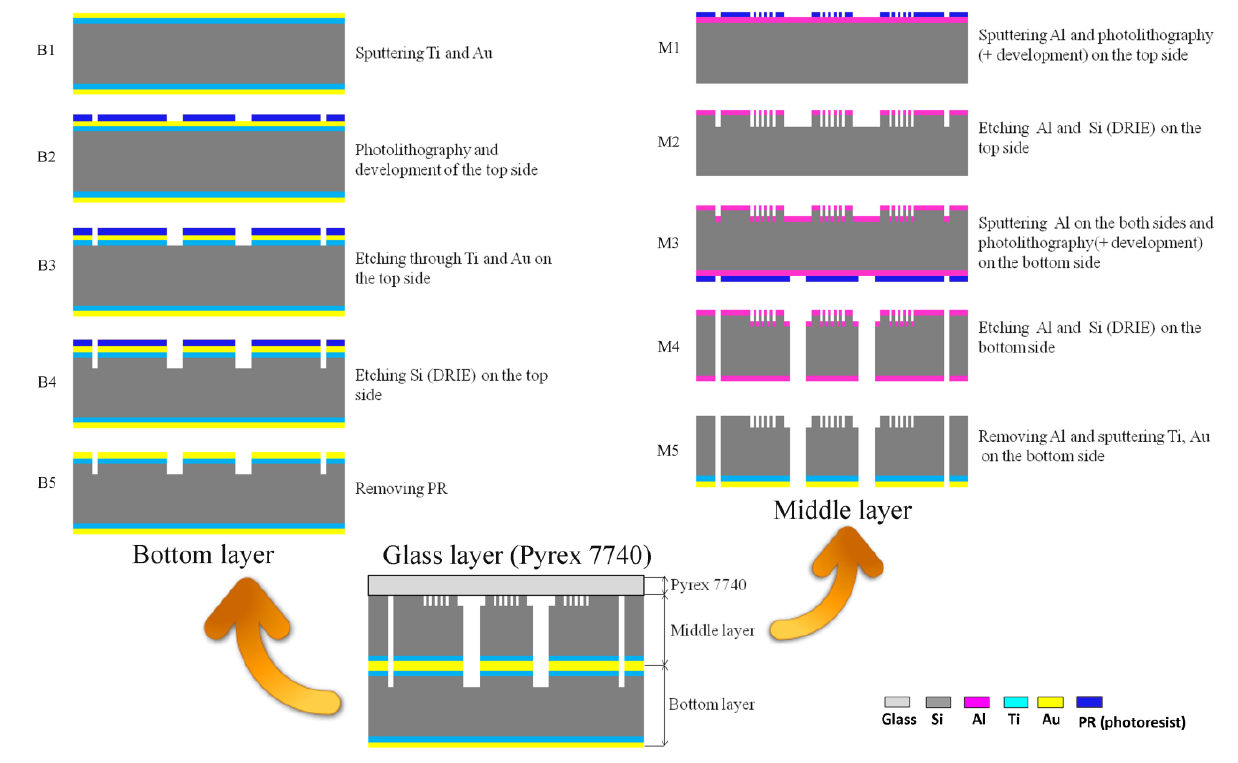
Figure 2. The process flow of the cell-based LOC device. ( a ) The fabrication steps of the bottom layer are marked from Step B1 to Step B5 and diagramed in the top left